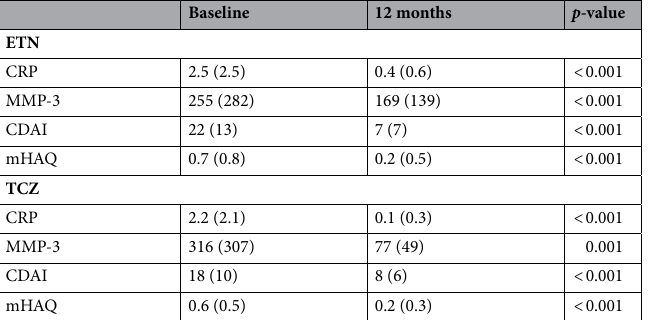
Table 2. Comparison of laboratory data and clinical outcome between baseline and 12 months after drug administration. Data represent as mean (standard deviation). ETN etanercept, TCZ tocilizumab, CRP C-reactive protein, MMP-3 matrix metalloproteinase-3, CDAI clinical disease activity index (CDAI); mHAQ modified health assessment questionnaire.